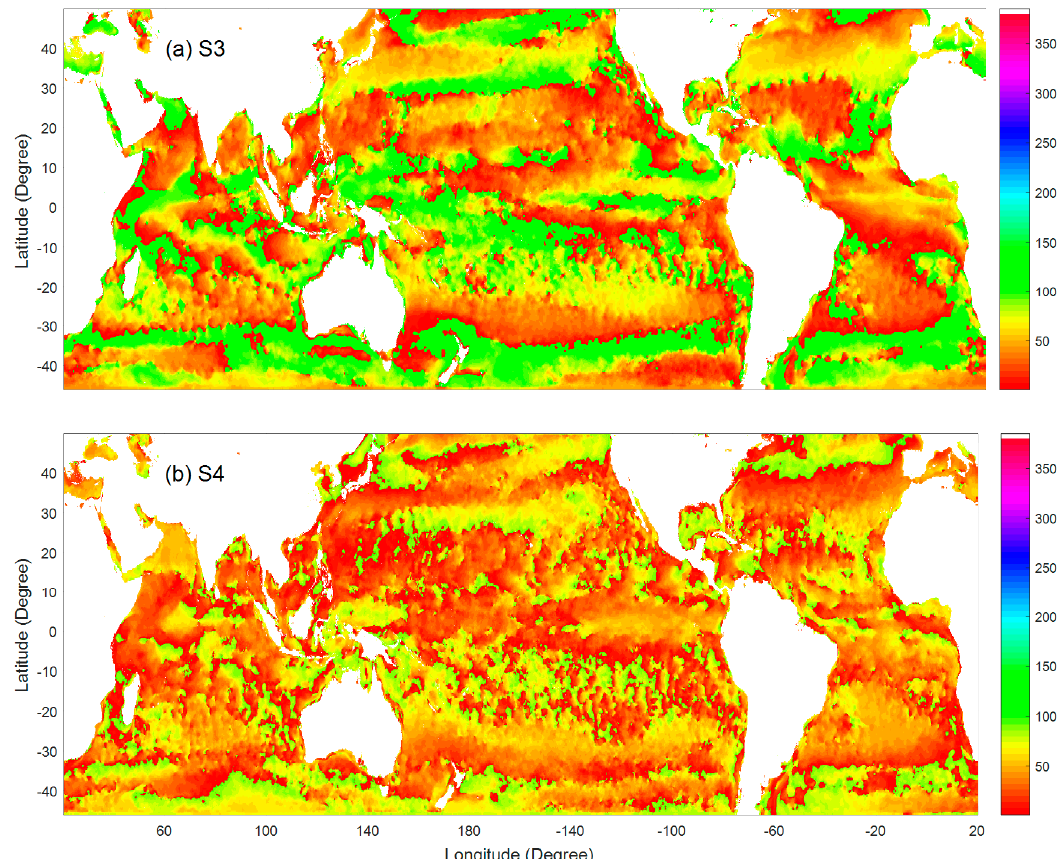
Figure 6. The phases of ( a ) and ( b ) fitted from Equation (3) in the unit of day of year.